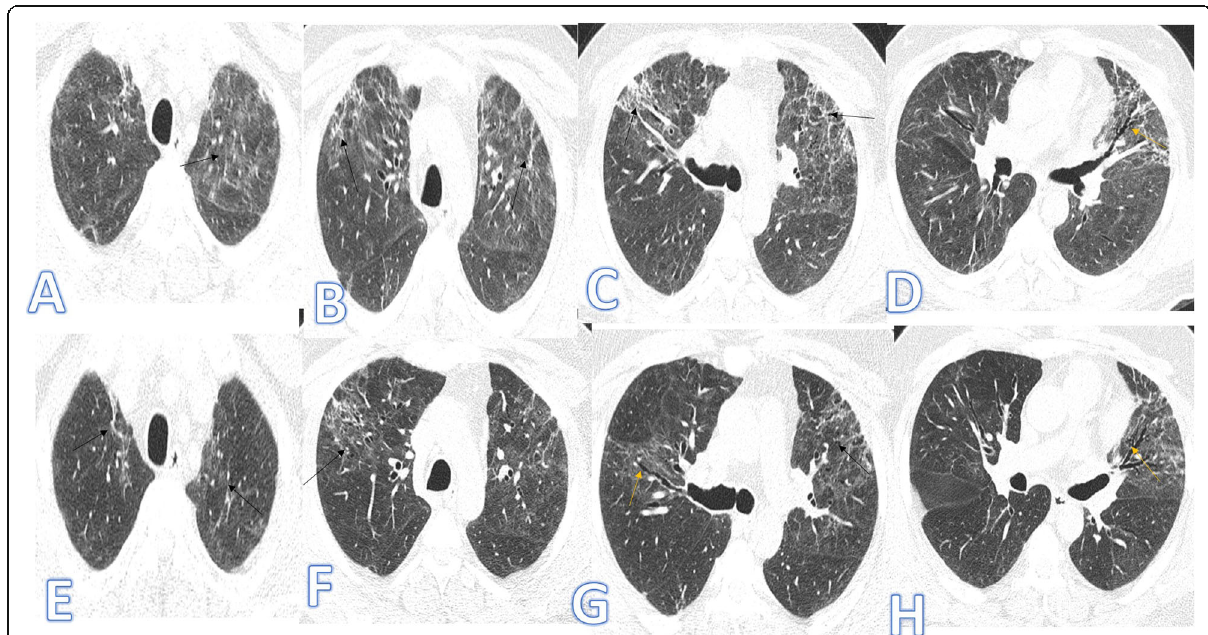
Fig. 3 Forty-three-year-old male, he has no past medical illness; peak CT severity score 18; consolidation/crazy-paving score 14. He was admitted to the ICU; laboratory results showed lymphopenia, high CRP, D -dimer, and serum ferritin. Steroid was given; length of stay during hospitalization is 65 days. CT after 3 weeks of admission ( a – d ) showed bilateral GGO with bilateral upper lobe fibrotic bands (arrows) and traction bronchiectasis (orange arrows). Follow-up CT 2 months after discharge ( e – h ) showed lung fibrosis with parenchymal bands, coarse reticular pattern (arrows), and mild traction bronchiectasis at the anterior segments of both upper lobes (orange